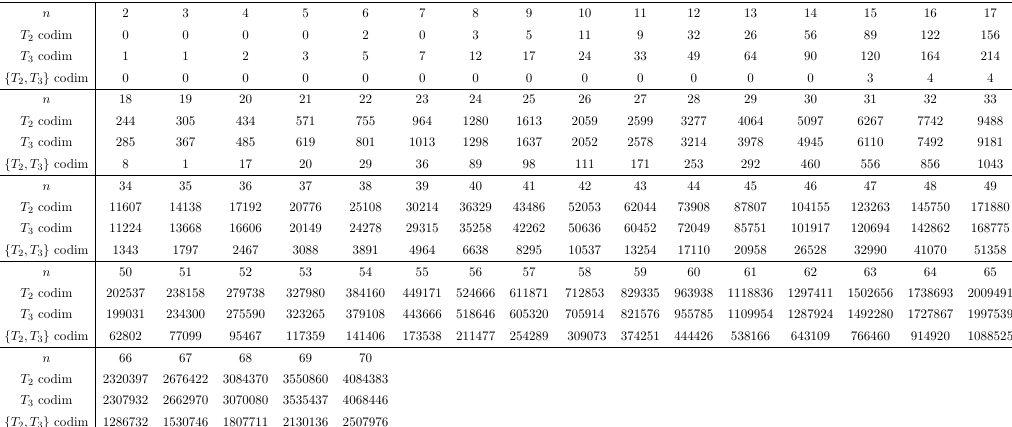
Table 1 . Table showing the codimension data for T to n = 70.